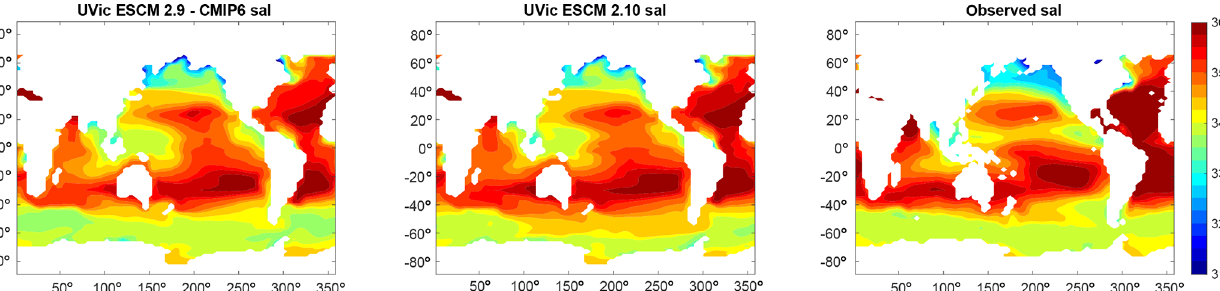
Figure 14. Maps of sea surface salinity (in practical salinity units; psu) for the published UVic ESCM version 2.9 (Eby et al., 2013) spun up and forced with CMIP6 forcing, for the UVic ESCM 2.10, and for the World Ocean Atlas 2018 (Zweng et al.,